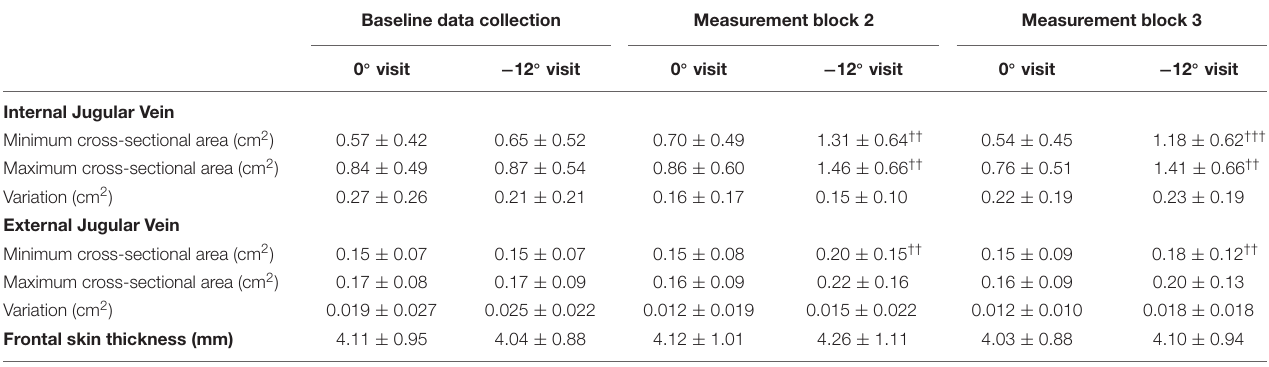
TABLE 5 | Jugular vein diameters and frontal tissue